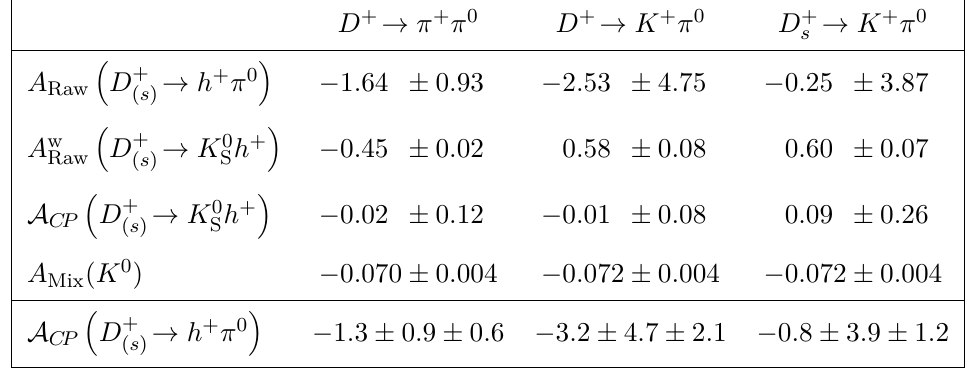
→ ( s ) → h + π 0 ) are ( s ) K + ) = 0 . 47 ± 0 . 05 and S